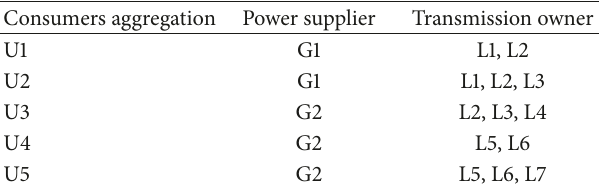
Table 1: Contractual relationship between the consumers aggrega- tions and power suppliers, transmission, owners.